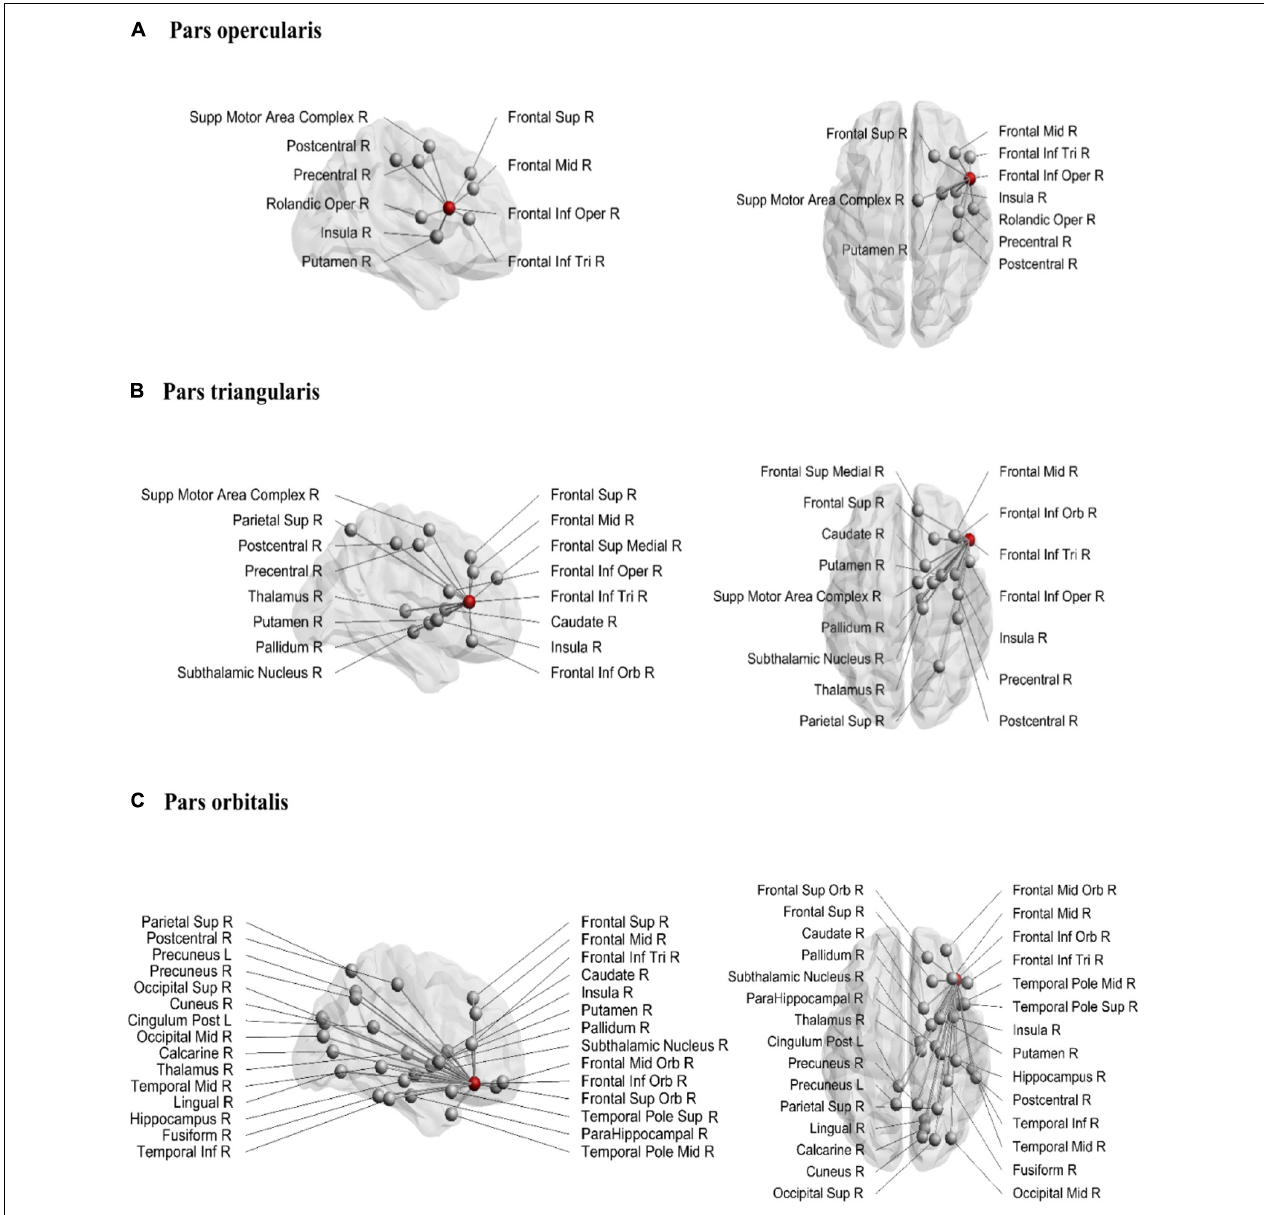
FIGURE 1 | Structural connections from pars opercularis (A) , pars triangularis (B) , and pars orbitalis (C) . The seeding region is marked as a red node. Sup, superior ; Inf, inferior ; Mid, middle ; Supp, supplementary ; Oper, opercularis ; Tri, triangularis ; Orb, orbitalis ; R, right ; L,